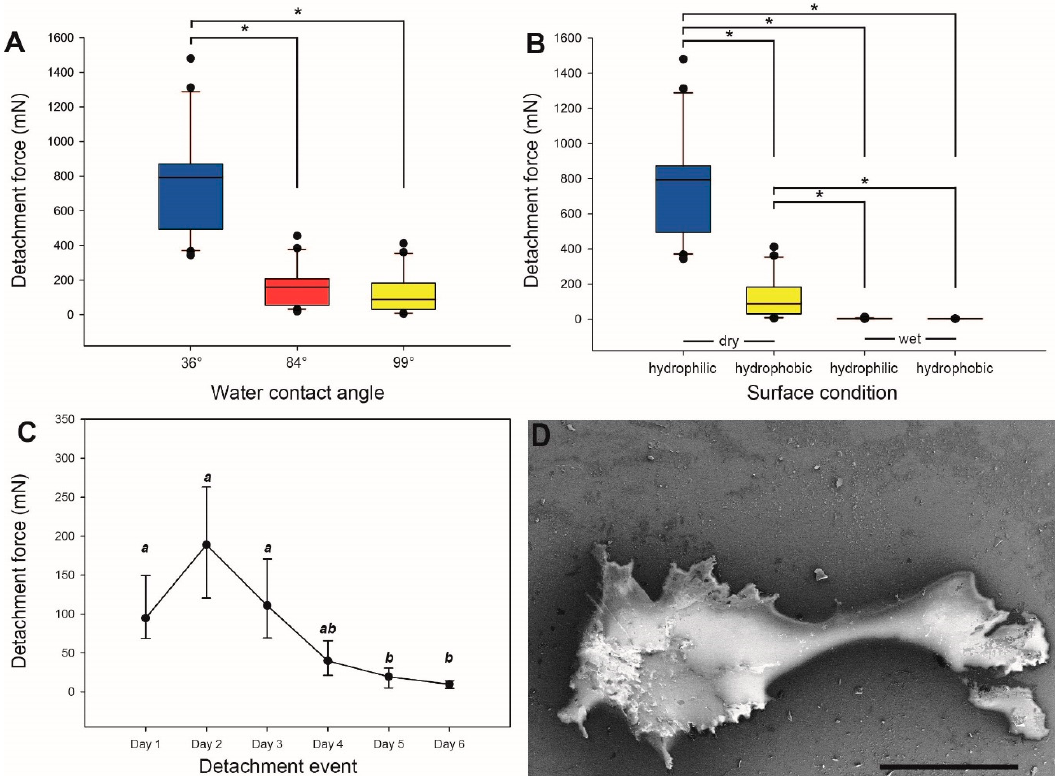
Figure 6. Influence of surface chemistry and repetitive detachment on Phyllium philippinicum eggs. ( A ) Detachment forces from surfaces with different water contact angles ( N = 20 for each contact angle). ( B ) Detachment forces from wet and dry surfaces with different chemical properties ( N = 20 for each treatment). “Hydrophilic” corresponds to a contact angle of 36° and “hydrophobic” corresponds to a 99° water contact angle. Boxes are 25 th and 75 th percentiles, the line within the boxes defines the median, and whiskers represent the 10 th and 90 th percentiles. * p ≤ 0.001, only significant comparisons are highlighted (Kruskal–Wallis one-way ANOVA on ranks followed by Tukey’s post hoc test). ( C ) Detachment forces during sequential detachment events ( N = 8 eggs). Dots indicate the median, whiskers represent the standard deviation. Lowercase letters indicate statistically similarity. Groups with the same letter are statistically equal (Friedman repeated measurements ANOVA, followed by Tukey’s test). ( D ) Scanning electron microscopy image of glue residuals on a smooth hydrophobic glass surface. Scale bar: 300 µm.